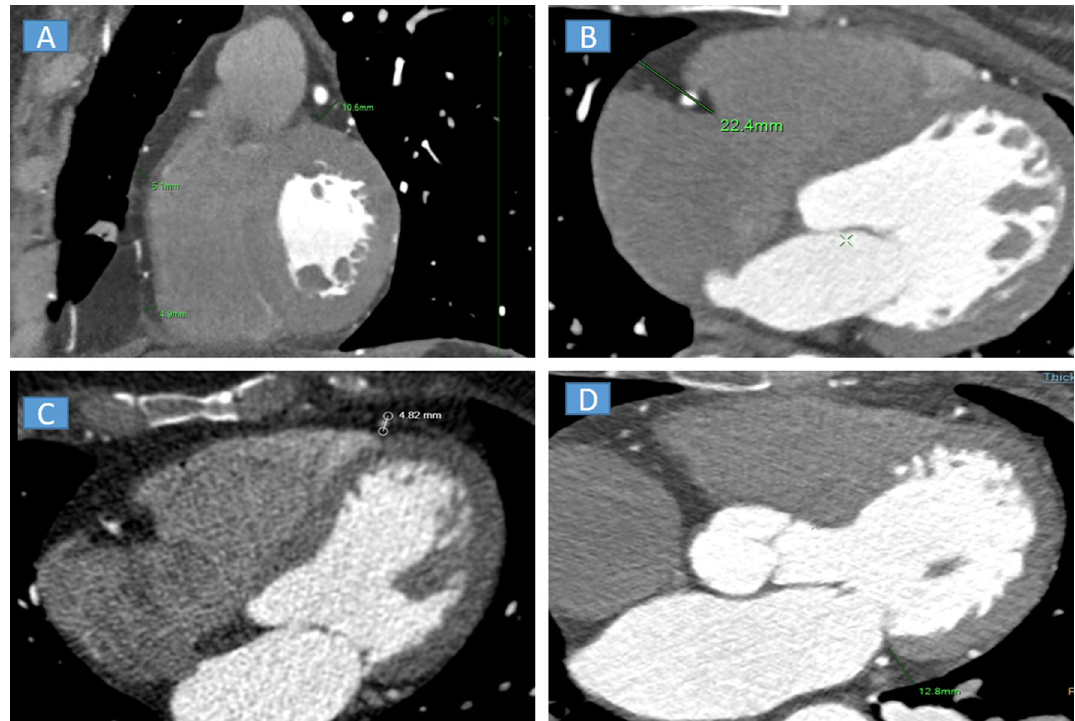
Fig. 1 Representative measurement of epicardial adipose tissue (EAT) thickness and pericoronary fat thickness (PCFT). A EAT thickness. B PCFT surrounding RCA. C PCFT surrounding LAD. D PCFT surrounding LCX. RCA, right coronary artery; LAD, left anterior descending artery; LCX,